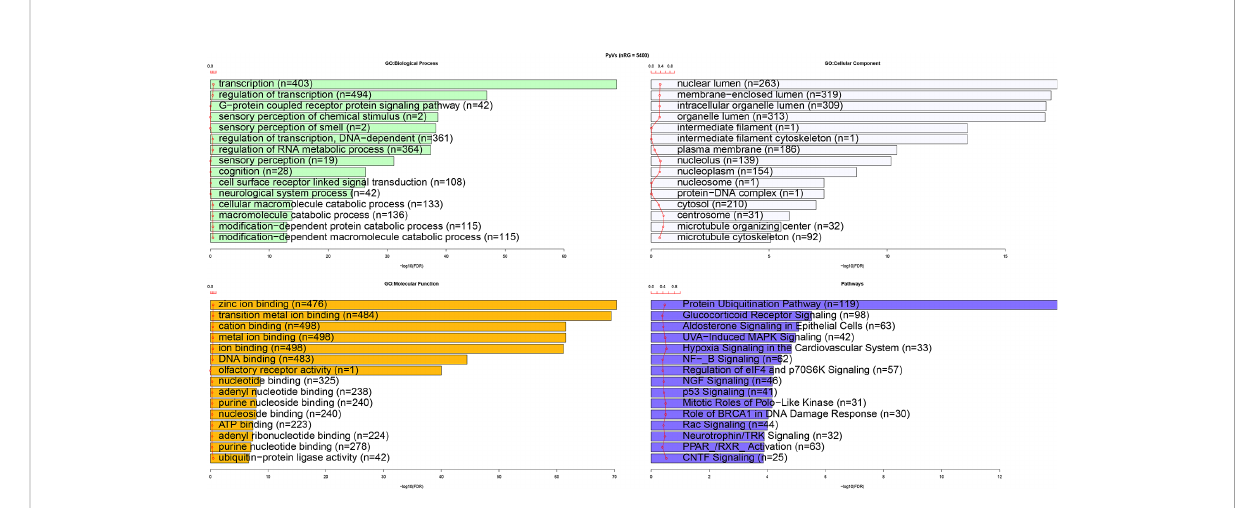
FIGURE 3 Functional enrichment analysis of human genes with CUB similar to that of